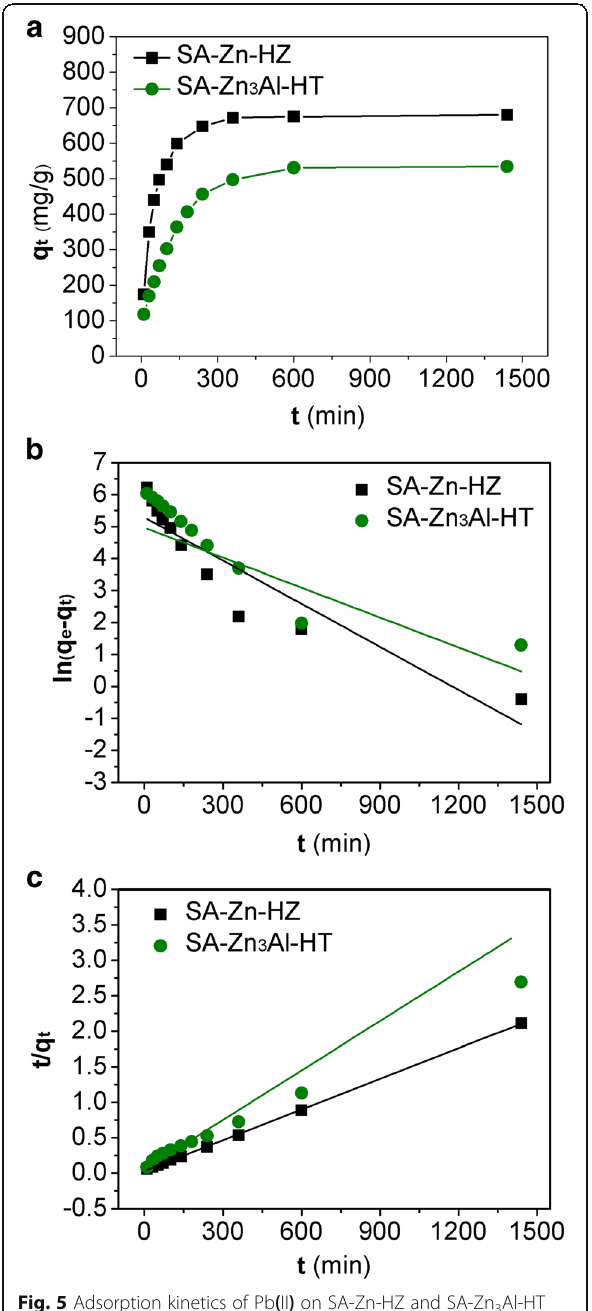
Table 2 The parameters of the Langmuir and Freundlich models fitted to the experimental data of Pb(II) adsorption on SA-Zn-HZ and SA-Zn 3 Al-HT Adsorbent q e , exp Langmuir model Freundlich model (mg g − 1 ) parameters Fig. 5 Adsorption kinetics of Pb ( II ) on SA-Zn-HZ and SA-Zn 3 Al-HT ( a ) and plots of the pseudo-first-order ( b ) and pseudo-second-order ( c ) adsorption kinetic models fitted for Pb(II) adsorption. Experiment conditions: initial Pb(II) concentration 500 ppm; adsorbent dose 0.5 g L − 1 ; contact time 0 ~ 24 h, solution pH 6.0 ± 0.1; temperature 30 °C